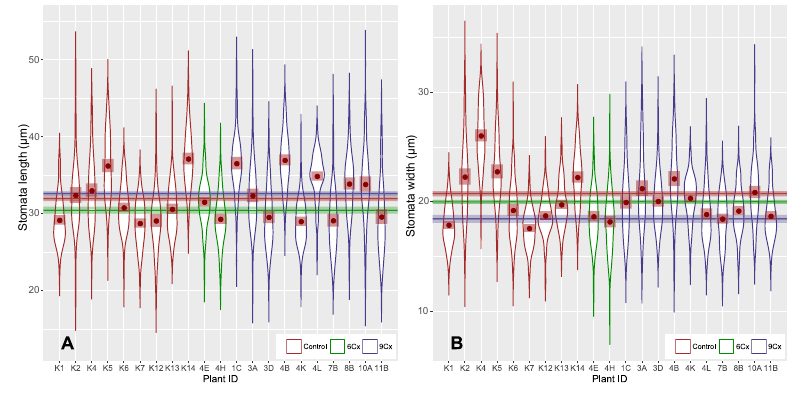
Figure 3 Stomatal length ( A ) and width ( B ) in seedlings (6Cx control) and endosperm-derived plants (6Cx and 9Cx regenerants). Graphs show the patterns of distribution of measurements of all analyzed individuals. Horizontal lines accompanied by semitransparent bands in appropriate colors show mean values and 95% confidence intervals (CI) for the measurement sets. Brown dots show the mean values for a given dataset, with 95% confidence intervals marked as semitransparent brown squares.